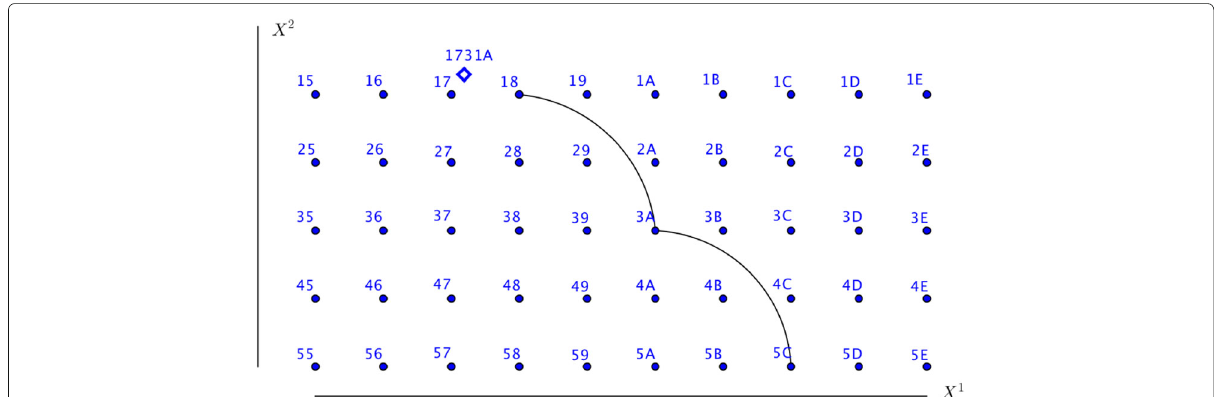
Fig. 7 Key search in a 2-d SHAM system. Following the address resolution procedure, node 5C forwards the query to node 3A from its routing table. Subsequently, 3A forwards the query to node 18. Based on key replication technique used in SHAM, node 18 will answer the query